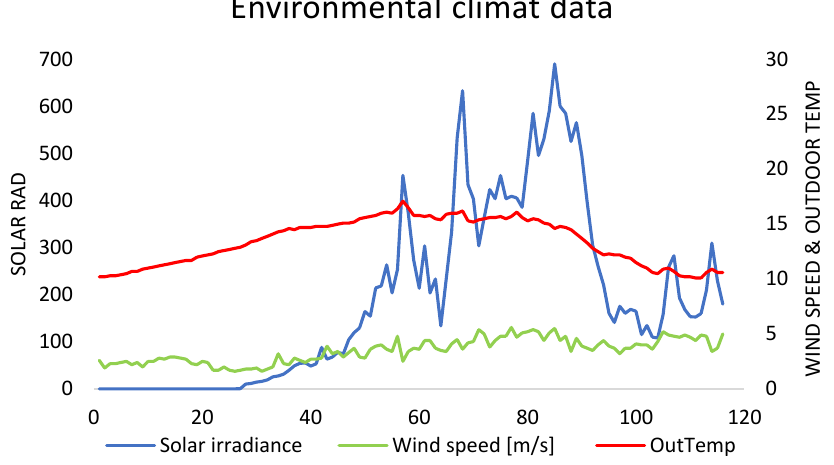
Figure 2. Solar irradiance (left scale), outdoor temperature, and wind speed (right scale). The greenhouse is equipped with a 2 kW heater (placed in the upper middle green rack), artificial lighting, natural ventilation, and three green planting racks consisting of two 50 W bulbs and one 25 W bulb. These heating bulbs were used as an additional IoT-supported heating system to maintain the desired microclimate temperature around the plant and were thus placed in the lower racks on the greenhouse floor. However, the greenhouse is simulated as a single input, single output (SISO) system. Only the centre sensor temperature reading was used as the output variable measurement of the system as shown in the control system schematic diagram in Figure 3 below.